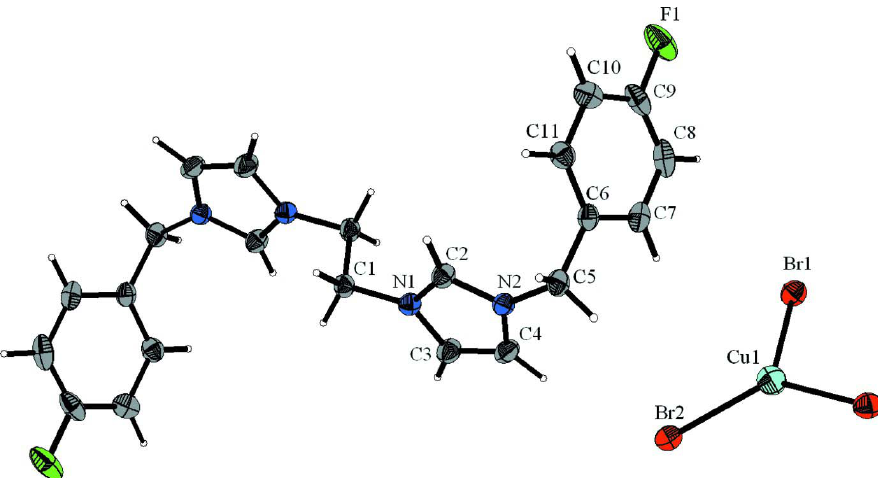
Figure 1 The structure of (I), showing 50% probability displacement ellipsoids for non-H atoms. H atoms are of arbitrary size. Unlabeled atoms of the imidazolium cation are related to labeled atoms by 3/2- x , 3/2- y , - z ; for the anion, the symmetry operation for Br1 is 1- x + 1, y , 1/2- z